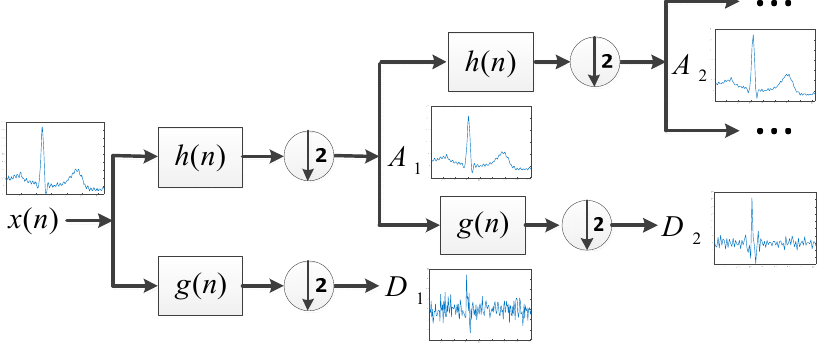
Figure 4. Heartbeat decomposition with discrete wavelet transform.